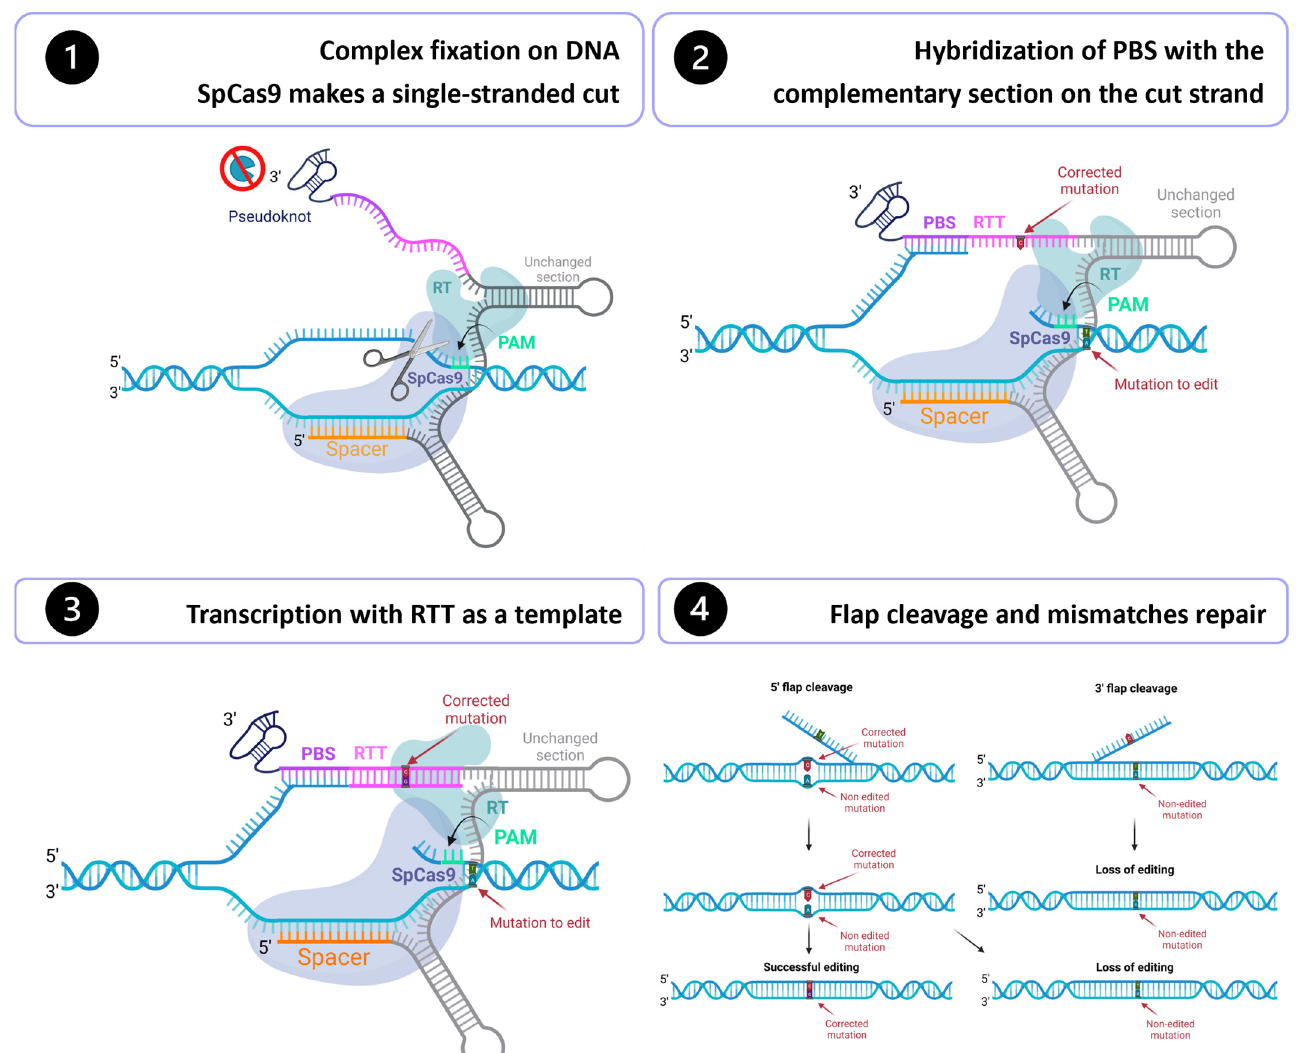
Figure 1. Prime editing mechanism. Step 1: Guided by the spacer sequence in the pegRNA, the Cas9